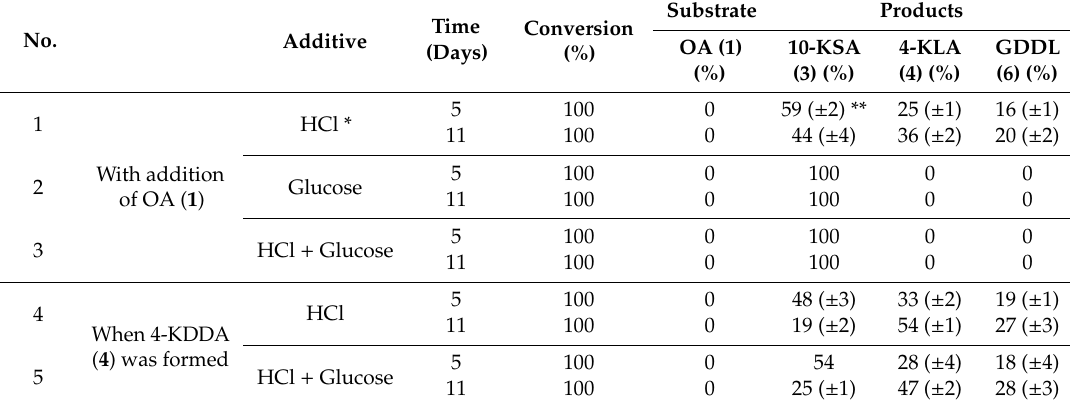
Table 3. E ff ect of pH and glucose supplementation (1%) on transformation of oleic acid ( 1 ) (0.25%)